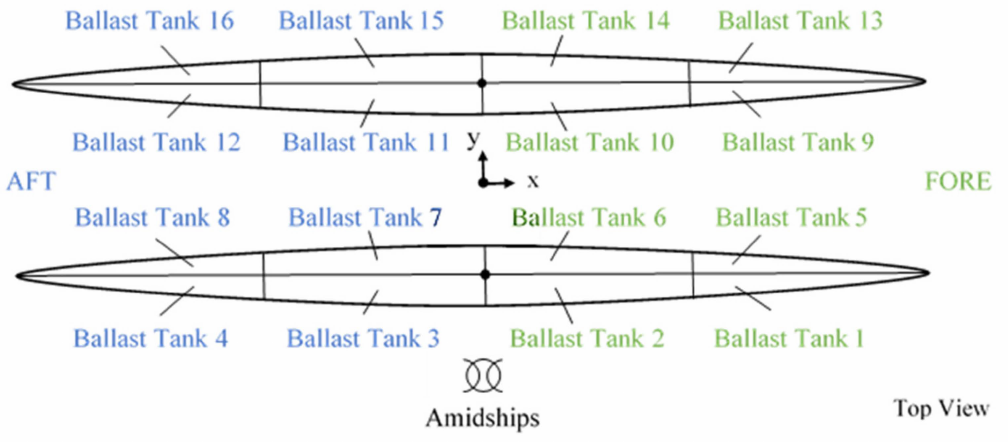
Figure 6. Ballast tank